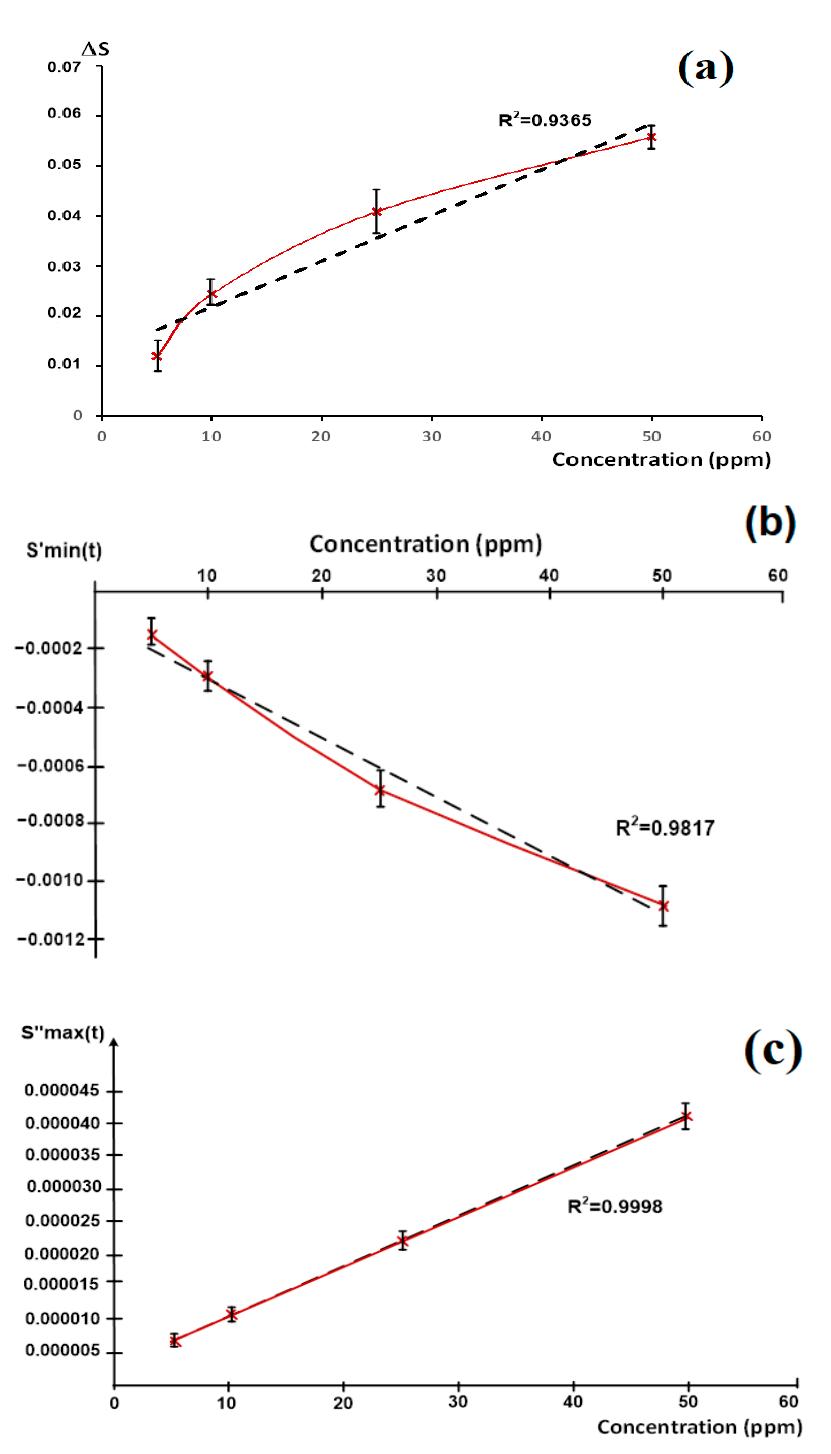
Figure 6. Calibration curves for NO 2 concentration estimation of Type 1 sensor ( a ) of the adsorption response Δ S at the saturation moment; ( b ) minimum of the first derivative S ′ ( t ); ( c ) maximum of the second derivative S ″ ( t ).